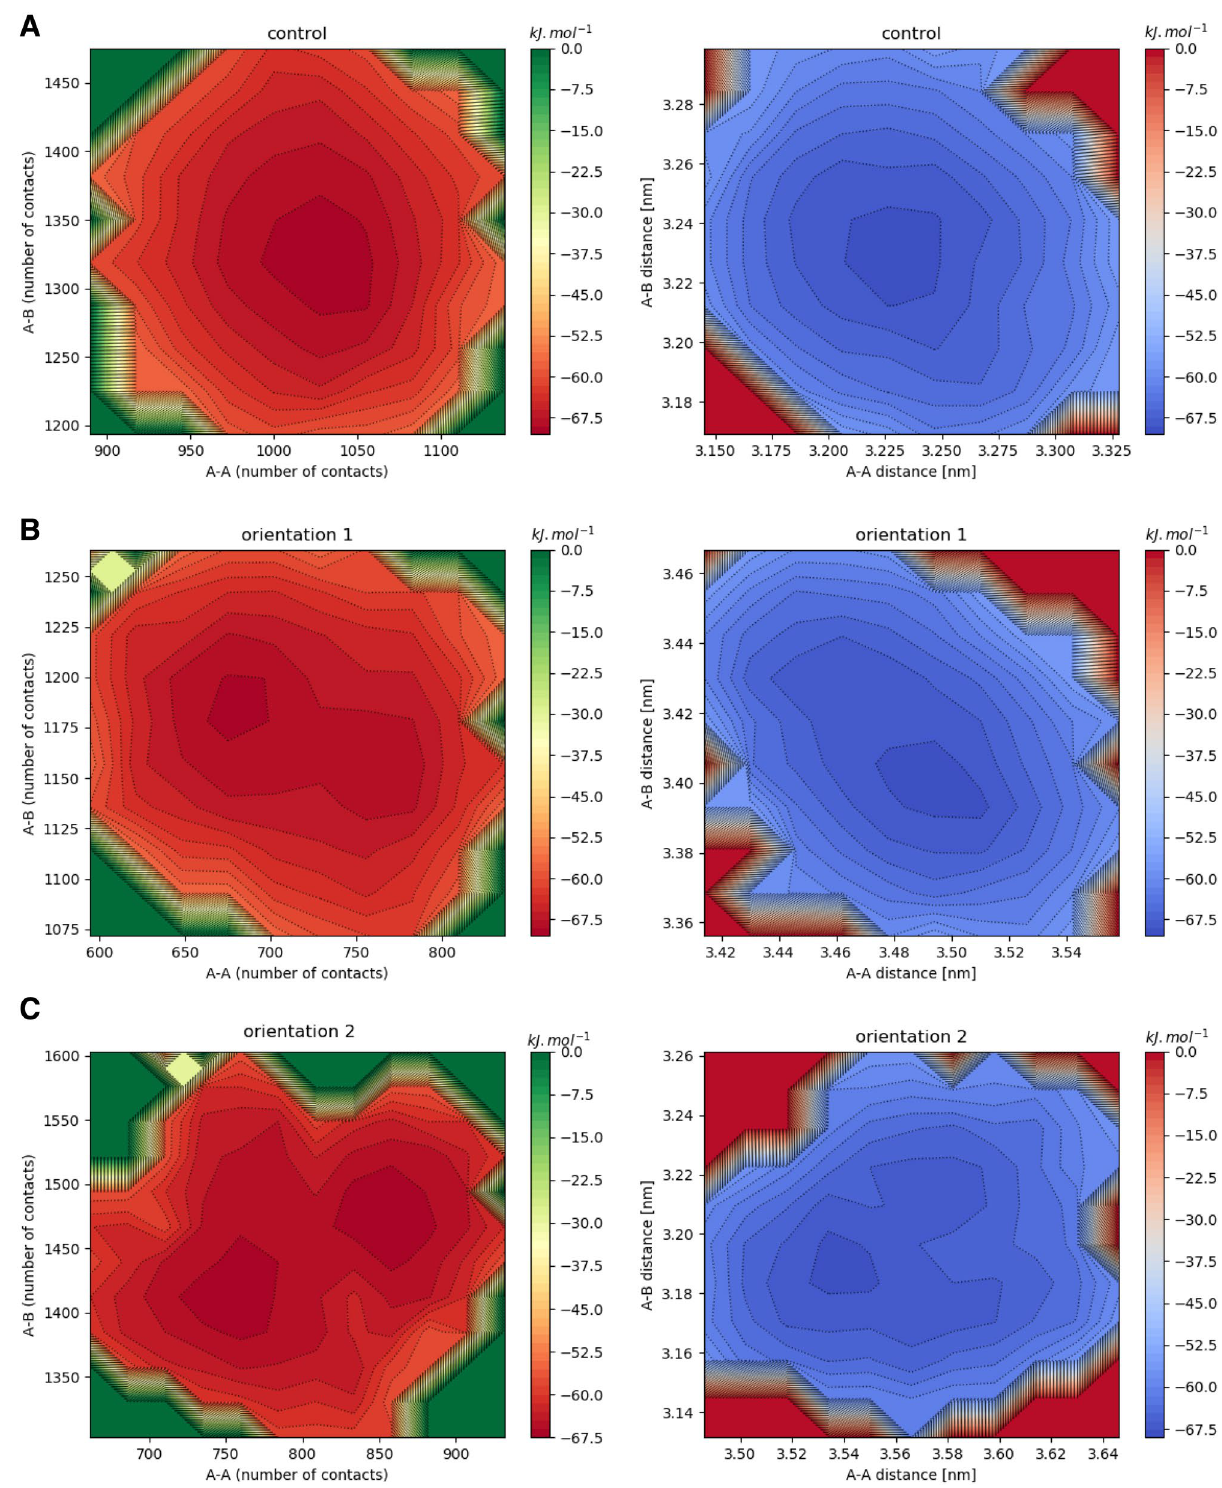
Figure 7. The 2D free energy plots. ( A – C ) The 2D free energy plots of distance actin-actin and actin-cofilin and number of contact actin-actin and actin-cofilin for control, orientation1, and orientation2. In this plot, actin-actin and actin-cofilin were shown by A–A and